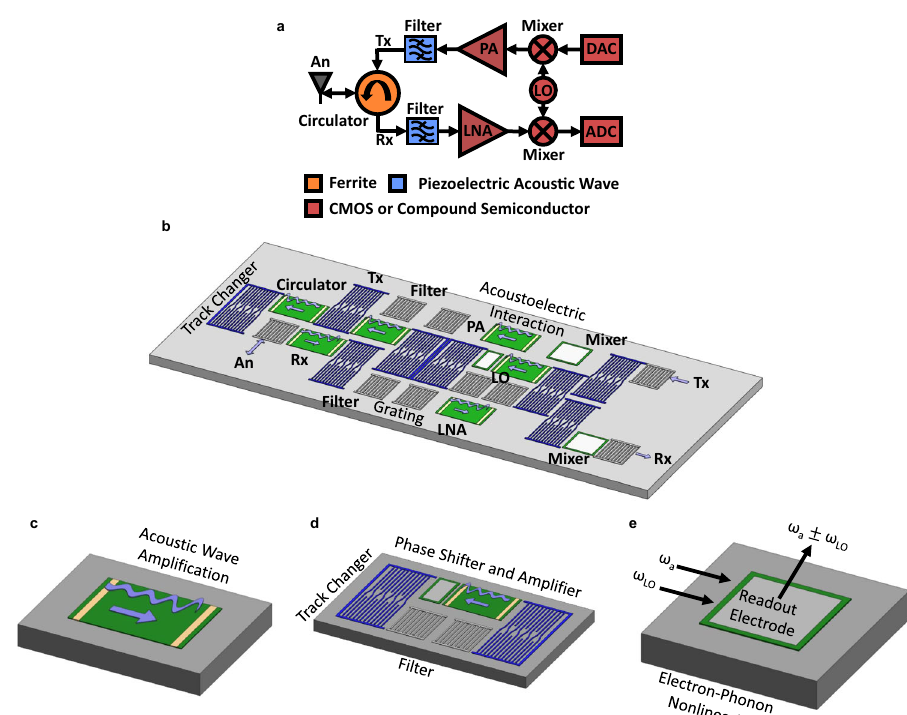
Fig. 6 RFSP overview and components of an all-acoustic RFSP. a Fundamental components of a multi-chip approach to an RF front end capable of STAR. The Tx and Rx paths are connected to the antenna (An) through a circulator. The Tx path requires a digital-to-analog converter (DAC) while the Rx path requires an analog-to-digital converter (ADC). b Schematic of an all-acoustic RF front end. The In 0.53 Ga 0.47 As is shown in green, the LiNbO 3 substrate in light gray, DC contacts in gold, aluminum fi lters in dark gray, and track changers in dark purple. Arrows in light purple indicate the direction of acoustic wave propagation. c A PA utilizes the acoustoelectric effect for acoustic wave ampli fi cation in a device design optimized for large RF power handling. d The LO is constructed from RMSCs, an acoustic fi lter, an acoustic ampli fi er, and an acoustic wave phase shifter. e An acoustic wave mixer could operate by the nonlinearity from the electron – phonon